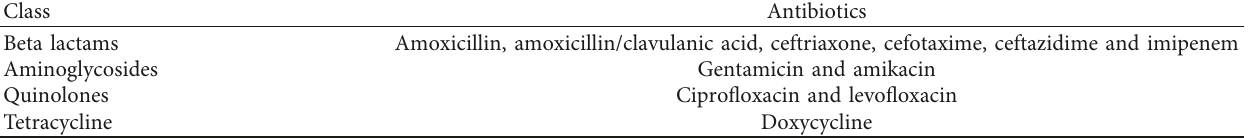
Table 1: Antibiotics